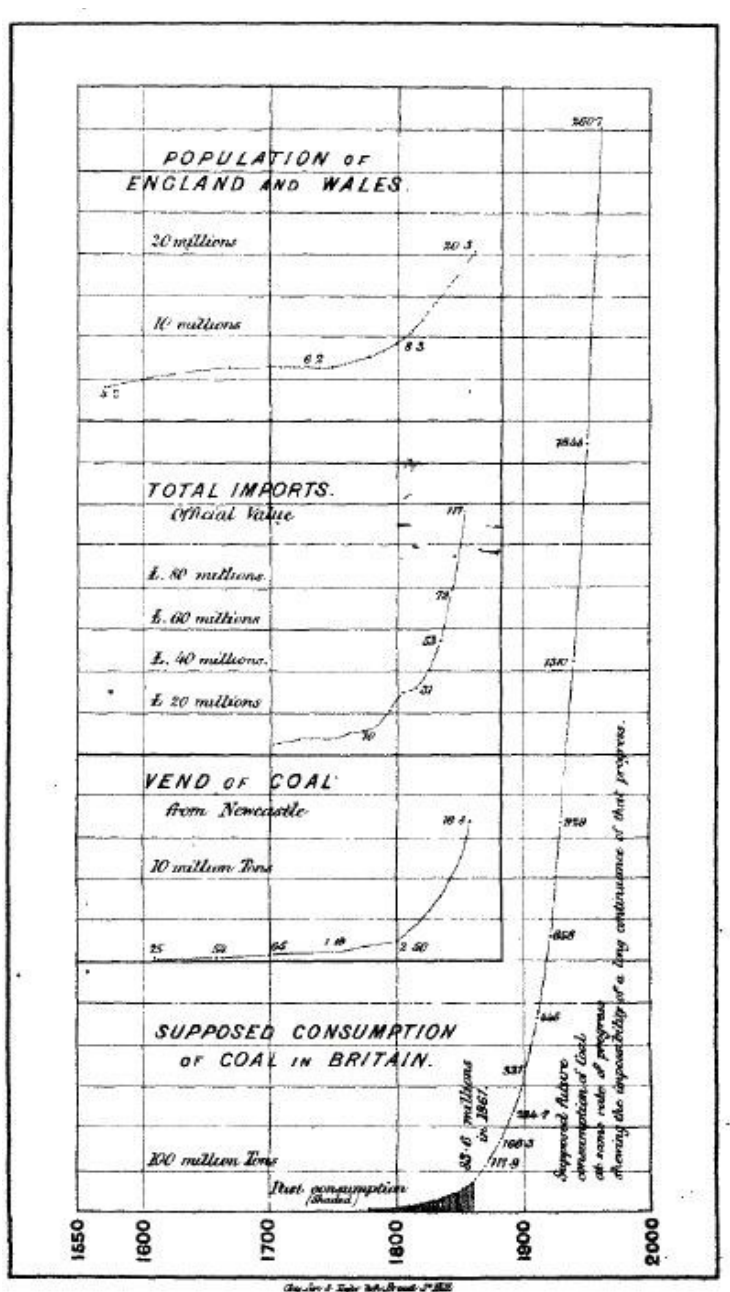
Figure 3. Digitalized image of the diagram depicted by Jevons to represent the rebound effect [113].